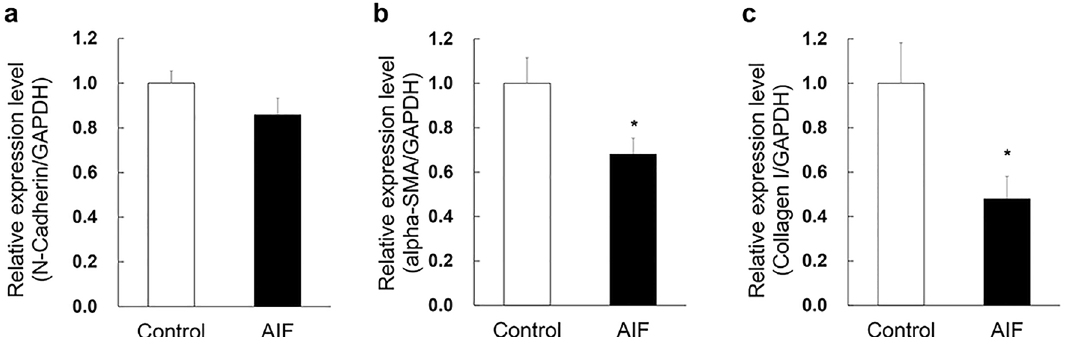
Figure 3. Inhibitory effects of alpinumisoflavone (AIF) on the expression fibrosis marker of ARPE-19 cells. ARPE-19 cells were treated with 5 µM AIF. AIF reduced the RNA expression level of ( b ) alpha smooth muscle actin (alpha-SMA) and ( c ) collagen I in ARPE-19 cell lysates. The statistical analysis was performed using Mann–Whitney U test (* p < 0.05 vs. control group) and the results are expressed as mean ± SEM (n = 3 biological replicates). qRT-PCR for each biological replicate was performed in duplicate.